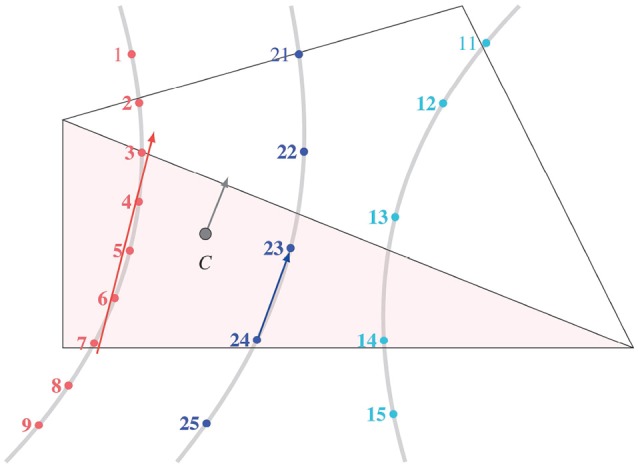
Effective fibre direction in an element. The points within a fibre strand created by MedINRIA were sequentially numbered. When more than one fibre strand passed through an element, the effective fibre direction at the element centroid C was computed by the weighted sum of the best fit lines from each strand.